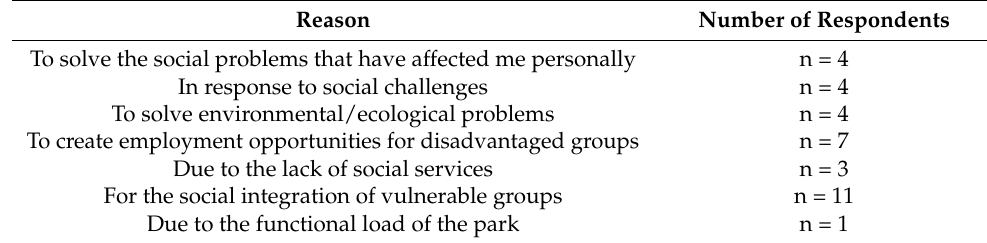
Table 1. Motivations for Founding a Social Enterprise.